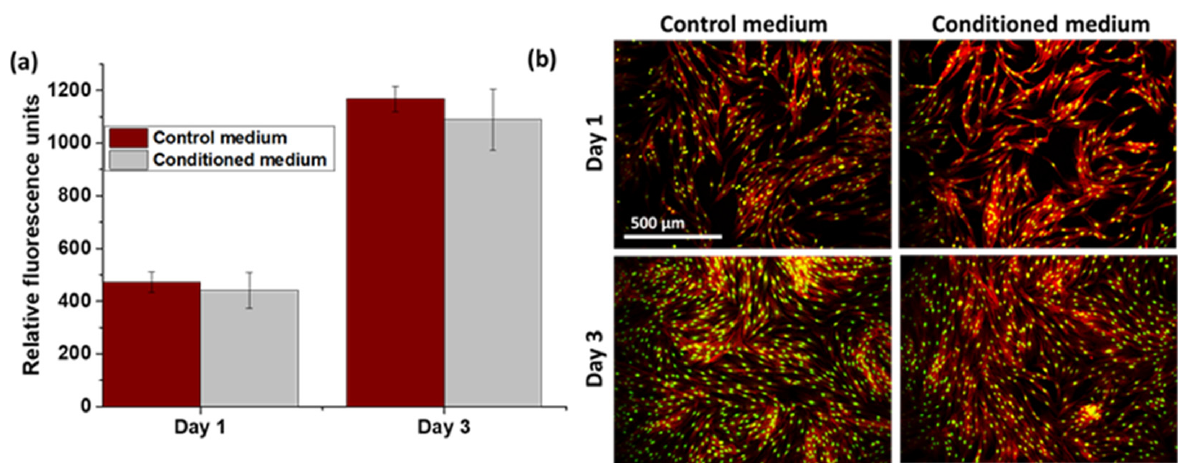
Figure 5. ( a ) AlamarBlue measurements of cell viability and proliferation at days 1 and 3 ( b ) Repre- sentative fluorescence micrographs at days 1 and 3. Green (nuclei) and Red (actin). ImageJ was used for better visualization of the cells.